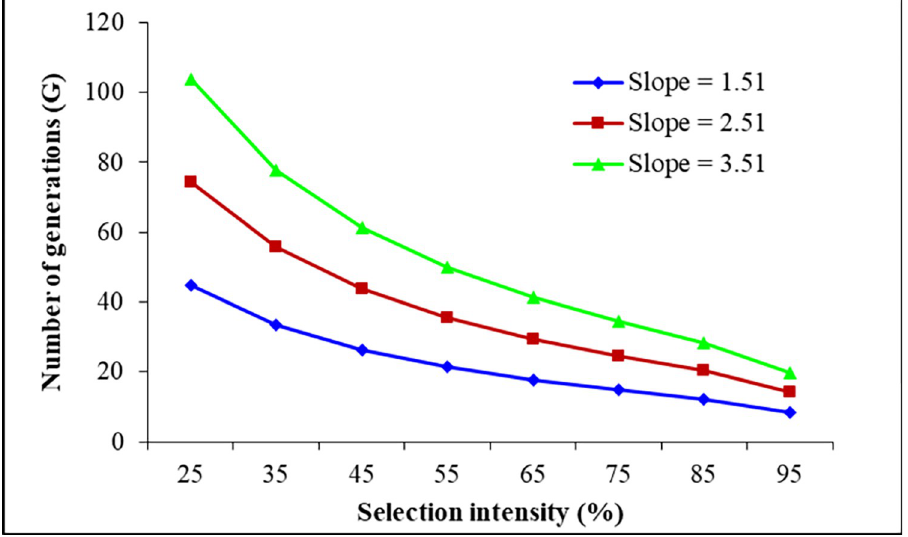
Fig 2. Effect of slope on the number of generations of M . domestica needed for a 10-fold increase in LC 50 for diflubenzuron at different selection intensities and constant value of h 2 (0.08).